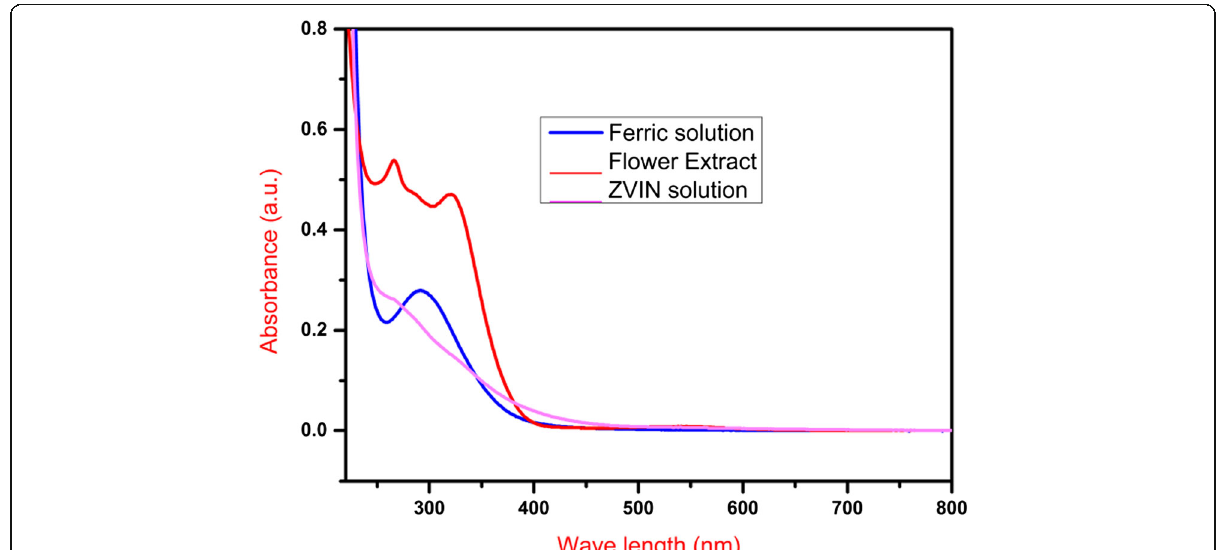
Fig. 1 The UV-vis absorption spectra of flower extract, ferric solution, and ZVIN